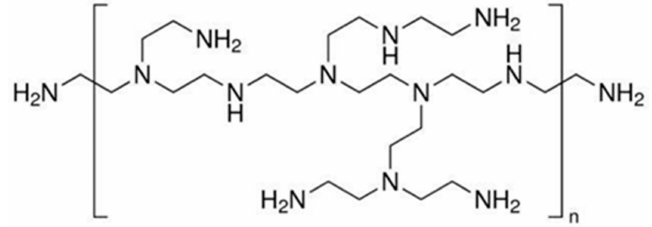
Figure 1. The structure of branched